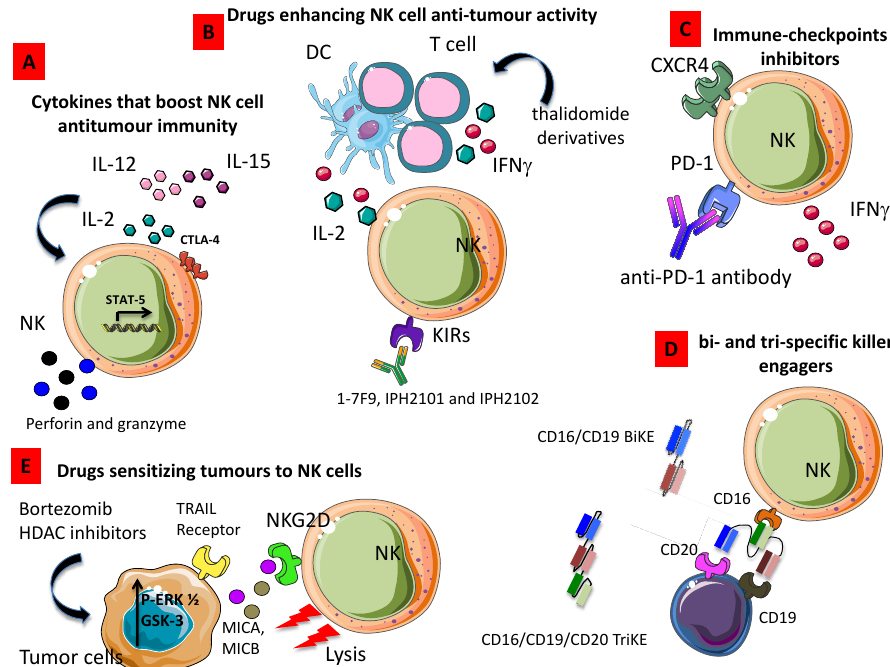
Figure 4. Strategies enhancing NK cell anti-tumor activity. ( A ) Cytokines such as IL-2, IL-15, and IL-12 alone or in combination can increase production and release of cytolytic granule content boosting NK cell anti-tumor immunity. ( B ) Drugs, including thalidomide derivatives, enhance the production of IFN- γ , thus triggering NK cell-mediated cytolysis. ( C ) Antibody directed to immune-checkpoints inhibitors like PD-1 can relieve the brake to NK cell cytolysis. ( D ) Bi- and tri-specific killer engagers strongly activate NK cell-mediated killing of tumor target cells. ( E ) Drugs able to sensitize tumors to upregulate ligands of activating receptors can increment killing of tumor cells; indeed, histone deacetylase inhibitors (HDAC) trigger the expression of NKG2DL such as MICA and MICB on tumor cells, these cells are more easily recognized and killed by NKG2D + NK